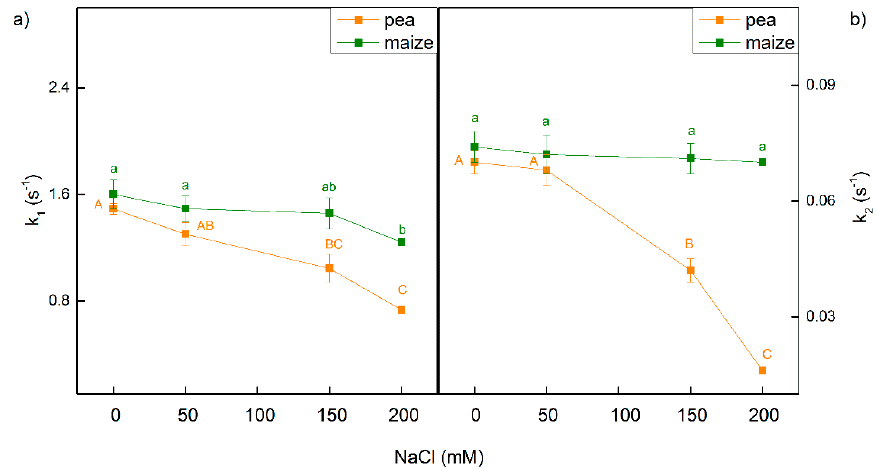
Figure 5. Effects of different NaCl concentrations on the dark relaxation of chlorophyll fluorescence induced by a single saturating light pulse in leaves of pea and maize. ( a ) Constant of the fast component (k 1 ); ( b ) constant of the slow component (k 2 ). Mean values (± SE) are from 10 independent measurements. Different letters indicate significant differences for the respective parameters at p < 0.05 (uppercase for pea and lowercase for maize).